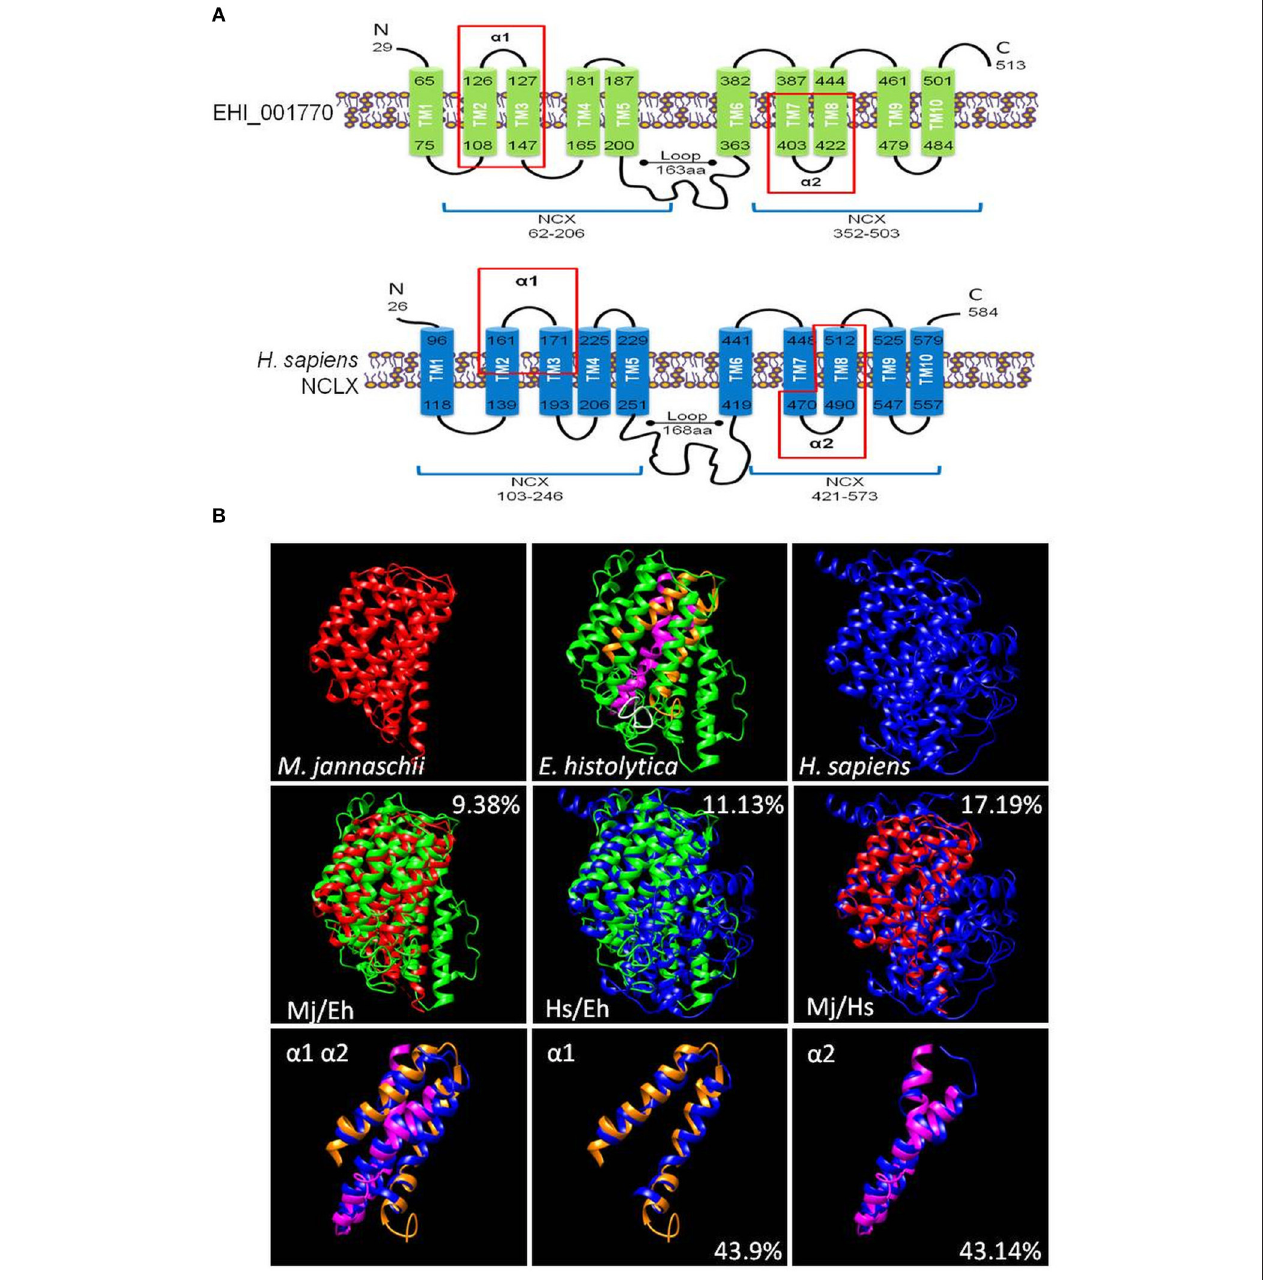
FIGURE 1 | In silico characterization of a calcium/cation exchanger of E. histolytica . (A) Secondary structure models of the putative calcium/cation exchanger of E. histolytica and the human NCLX. The signal peptides were eliminated in the models. Numbers indicate the amino acid position. Bars represent the transmembrane regions (TM1 to TM10). The protein segments that correspond to the NCX domains are indicated by blue lines below the models. Red rectangles showed the protein segments corresponding to the α 1 and α 2 repeats. (B) The 3D models of the E. histolytica exchanger (green) and the human NCLX (blue) were predicted by the I-TASSER server using the crystallized sodium/calcium exchanger of Methanococcus jannaschii NCX (red) as a template. The white portion in the 3D model of the E. histolytica protein represents the peptide used to obtain specific antibodies against it, whereas orange and magenta segments correspond to the α 1 and α 2 repeats, respectively. The overlapping of the 3D models of the whole proteins as well as of the α 1 and α 2 domains are also shown. Numbers indicate the percentage of structural identity.